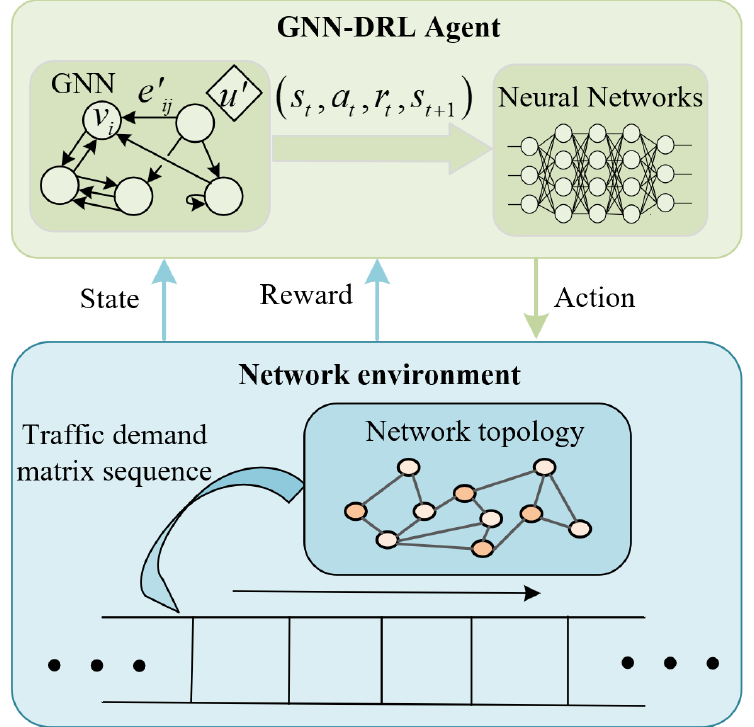
Figure 4. The interaction process between the GNN-DRL agent and the